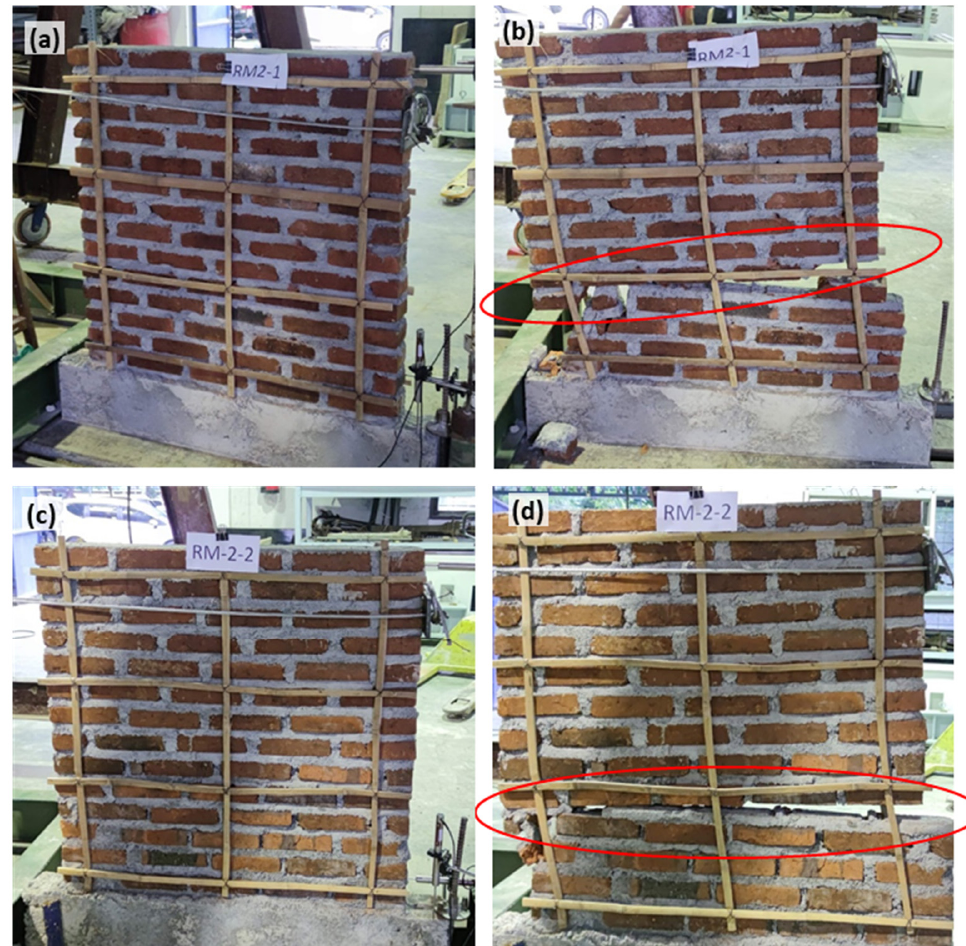
Figure 18. The pushover shear test and crack patterns of the retrofitted masonry panels with 1.44% of bamboo retrofitting: ( a , b ) RM2-1, and ( c , d ) RM2-2.